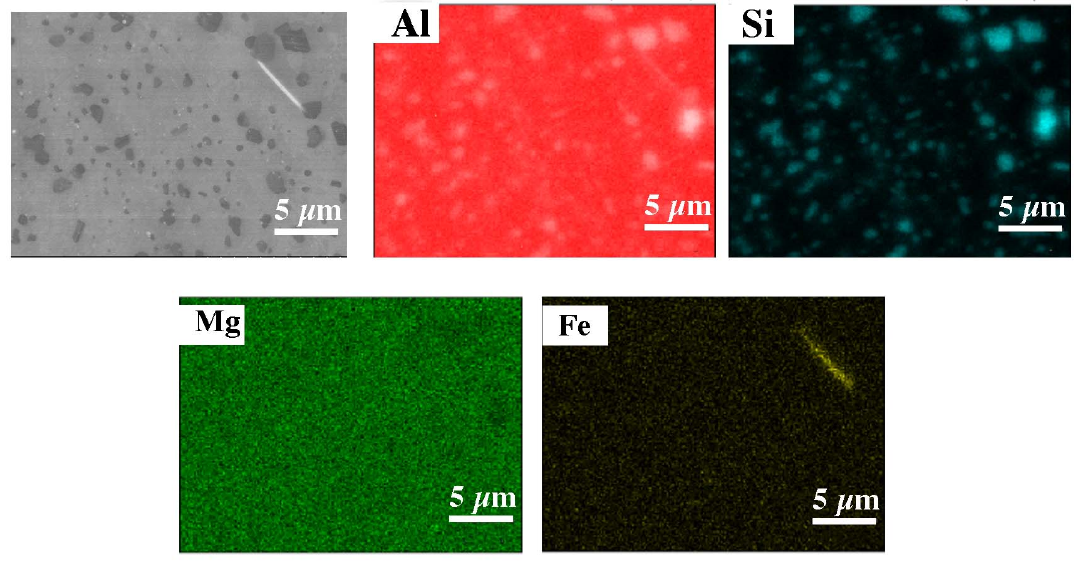
Figure 14. Map of the distribution of elements for the sample after supersaturation (EDS) . It was observed that Fe-reach precipitates are both needle-shaped and very